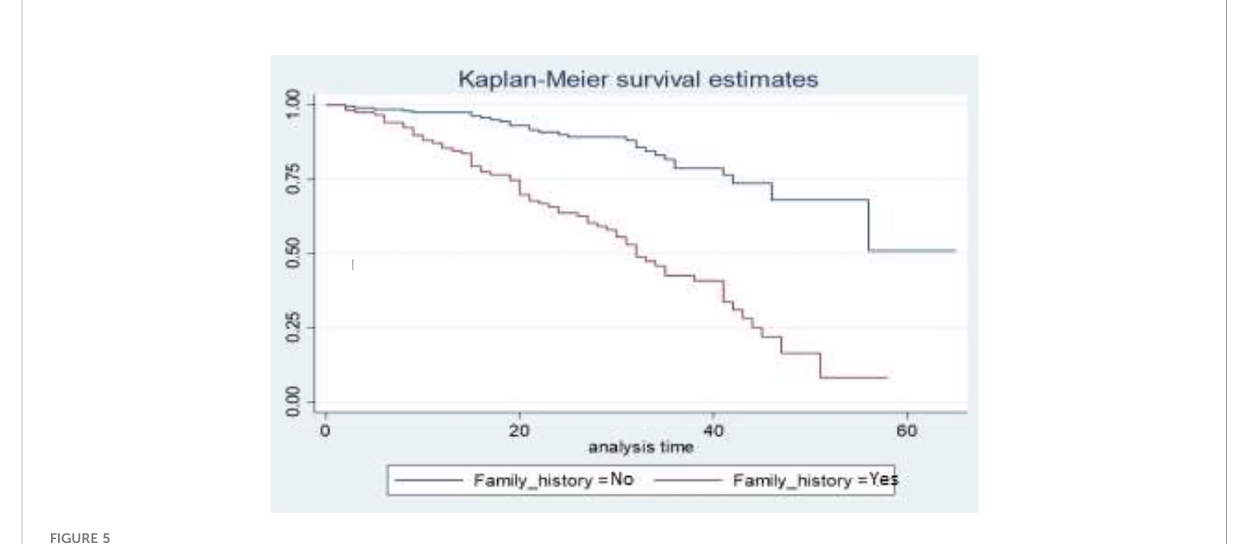
FIGURE 5 Survival curves for family history.